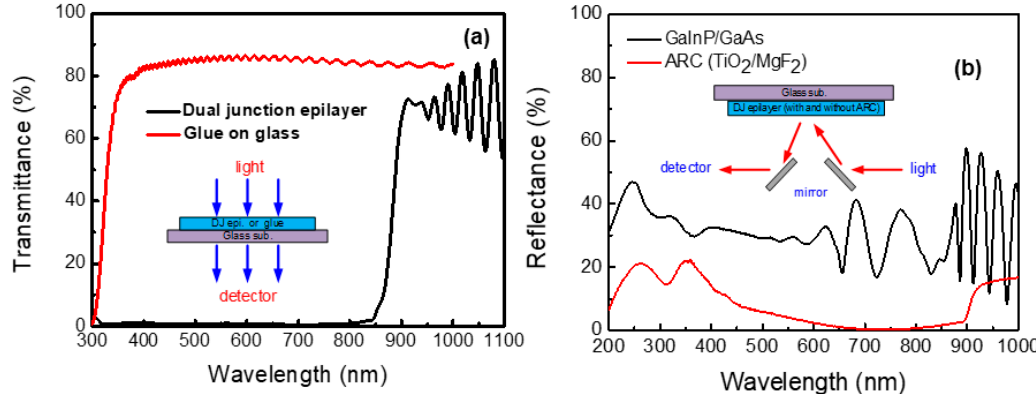
Figure 3. ( a ) Transmission spectra of the GaInP/GaAs dual-junction solar cell and glue on the glass substrate and ( b ) reflectance of DJ epilayer/glass with and without ARC.